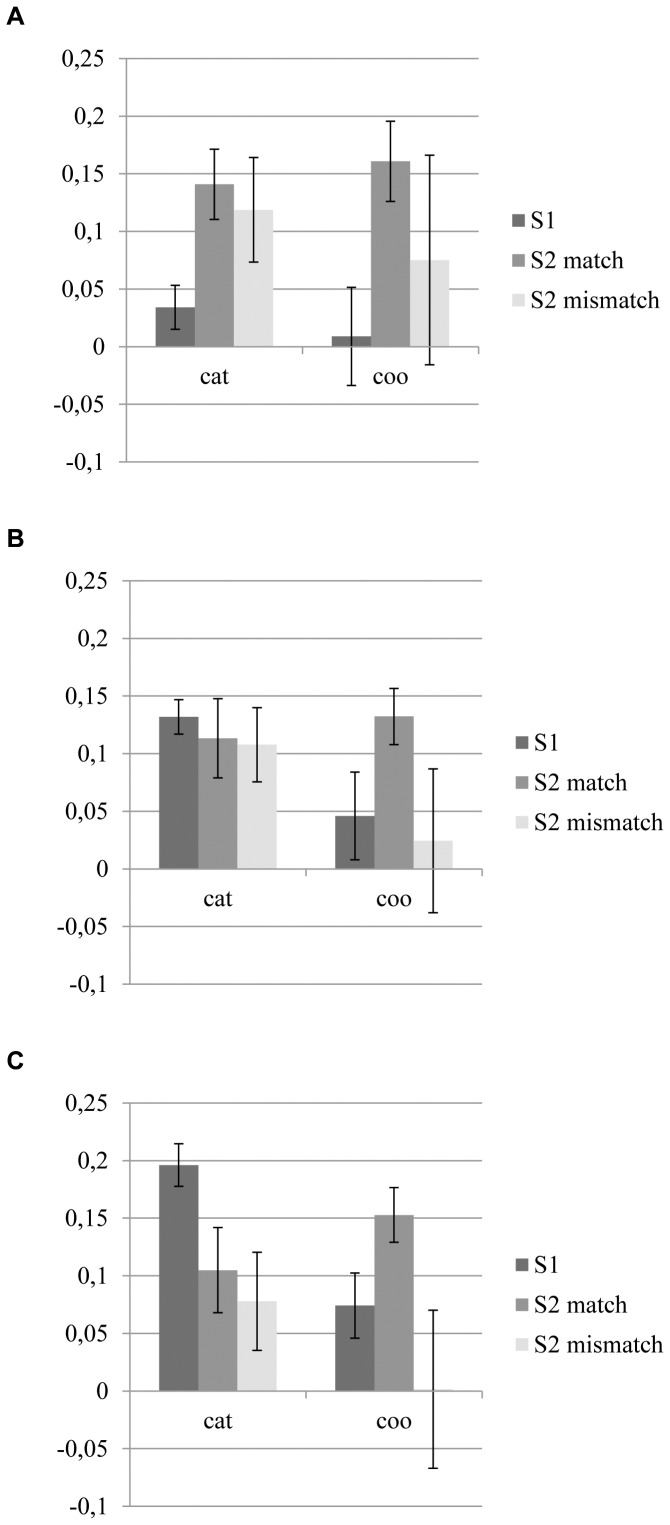
Mean regression coefficients related to all three stimulus types for A) V1, B) V2, and C) V3.Means are presented for both the categorical (cat) and coordinate instruction (coo) as well as the first stimulus (S1), the matching region of the second stimulus (S2 match), and the mismatching region of the second stimulus (S2 mismatch). Error bars represent the standard error of the mean (SEM).